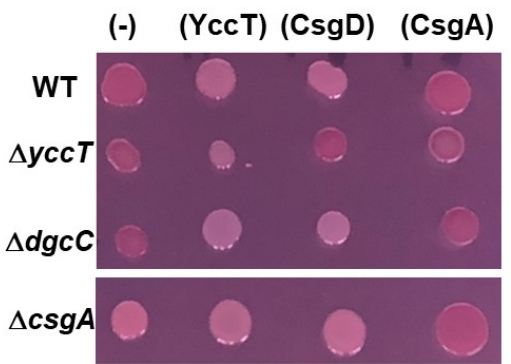
Figure 2. Inhibition of curli fimbriae formation through YccT overexpression. Curli fimbriae for- mation was tested by Congo red staining. Each strain (wild ‐ type: WT or with a yccT [ Δ yccT ], dgcC [ Δ dgcC ], or csgA [ Δ csgA ] deletion) were transformed with the control vector pBAD18 ( − ), pBADyccT (YccT), pBADcsgD (CsgD), or pBADcsgA (CsgA). Cells were spotted and incubated on a Congo red YESCA plate in the presence of 0.2% arabinose at 28 °C for 2 days.